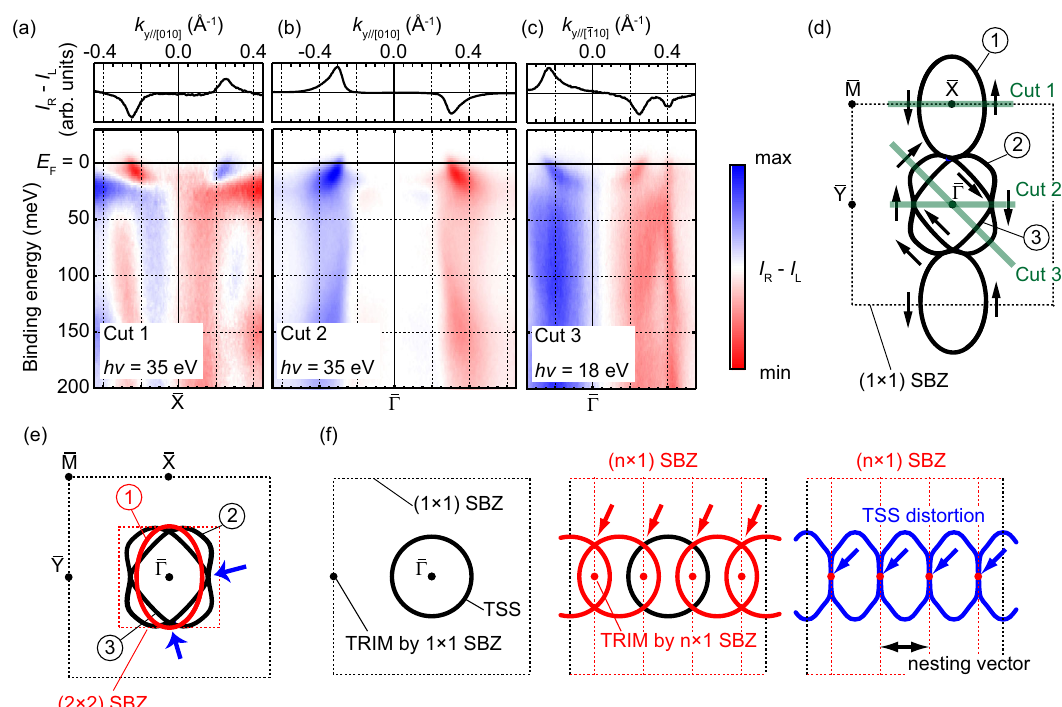
Fig. 4 | CD-ARPES band dispersions. a – c CD-ARPES plots taken at 13K. The measurement geometries are the same as those in Figs. 2 and 3. d Schematic drawing of the OAM polarizations corresponding to surface FCs, assuming that they are parallel to the helicities of the incident-photon polarizations: parallel (anti-parallel) to the photon-incidence vector for right- (left-) handed